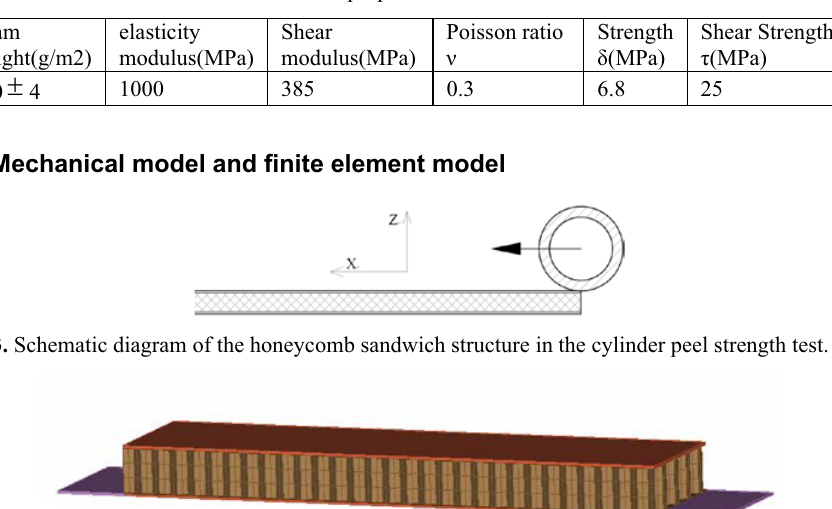
Table 3. The properties of Hansort 4301.